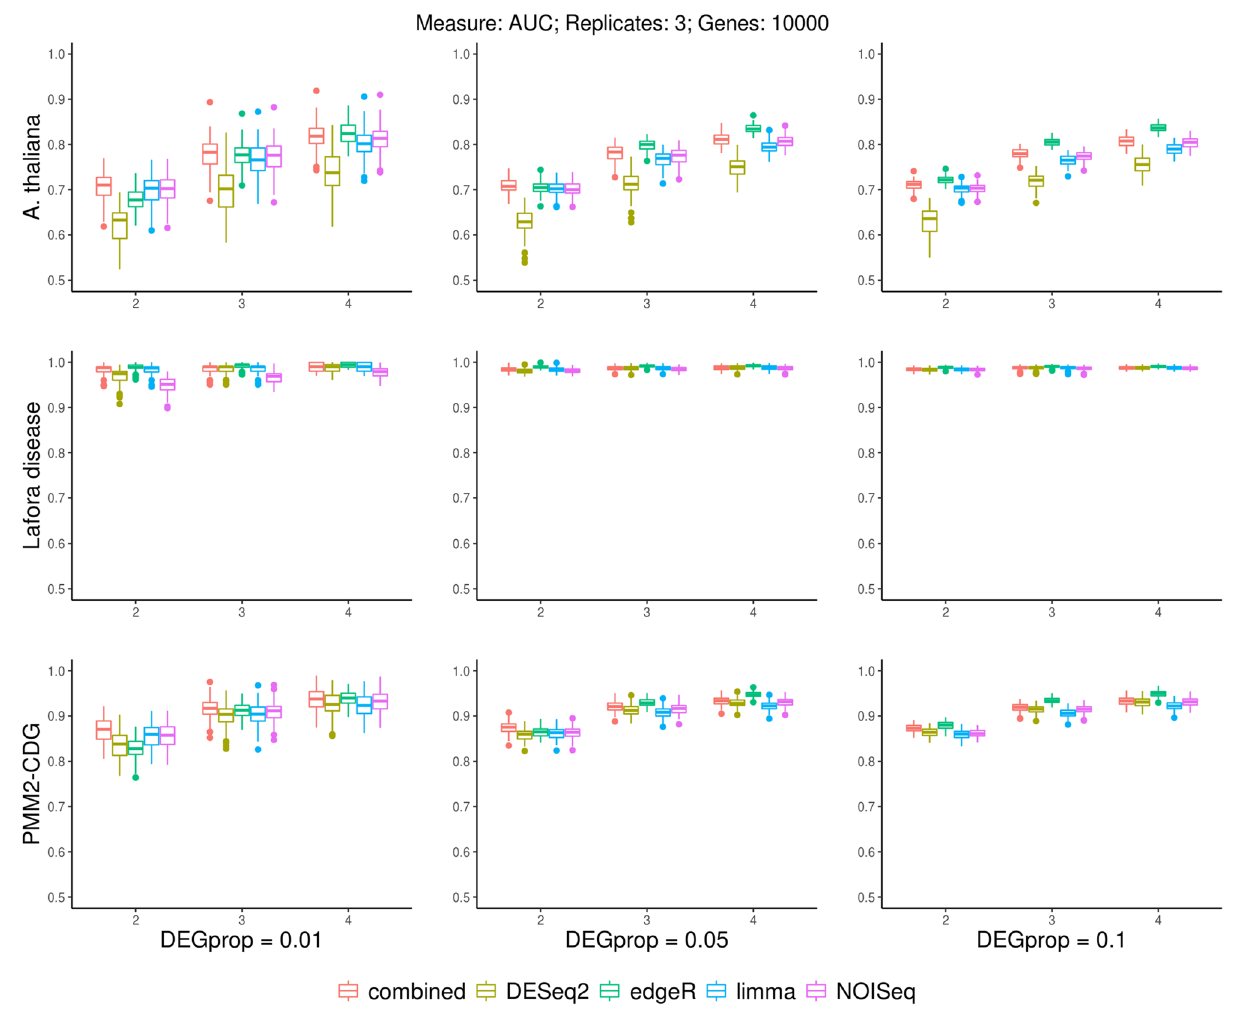
Figure 2. Boxplots showing area under the curve (AUC) for different DEG detection methods applied to a range of simulated datasets. The datasets shown include three replicates and 10,000 genes. Plots are grouped by experiment from which the simulated dataset was derived (rows) and proportion of simulated DEGs (columns). Within each plot different values of simulated log2 fold change values for the DEGs are shown (x-axis). Boxplot colours represent different DEG detection